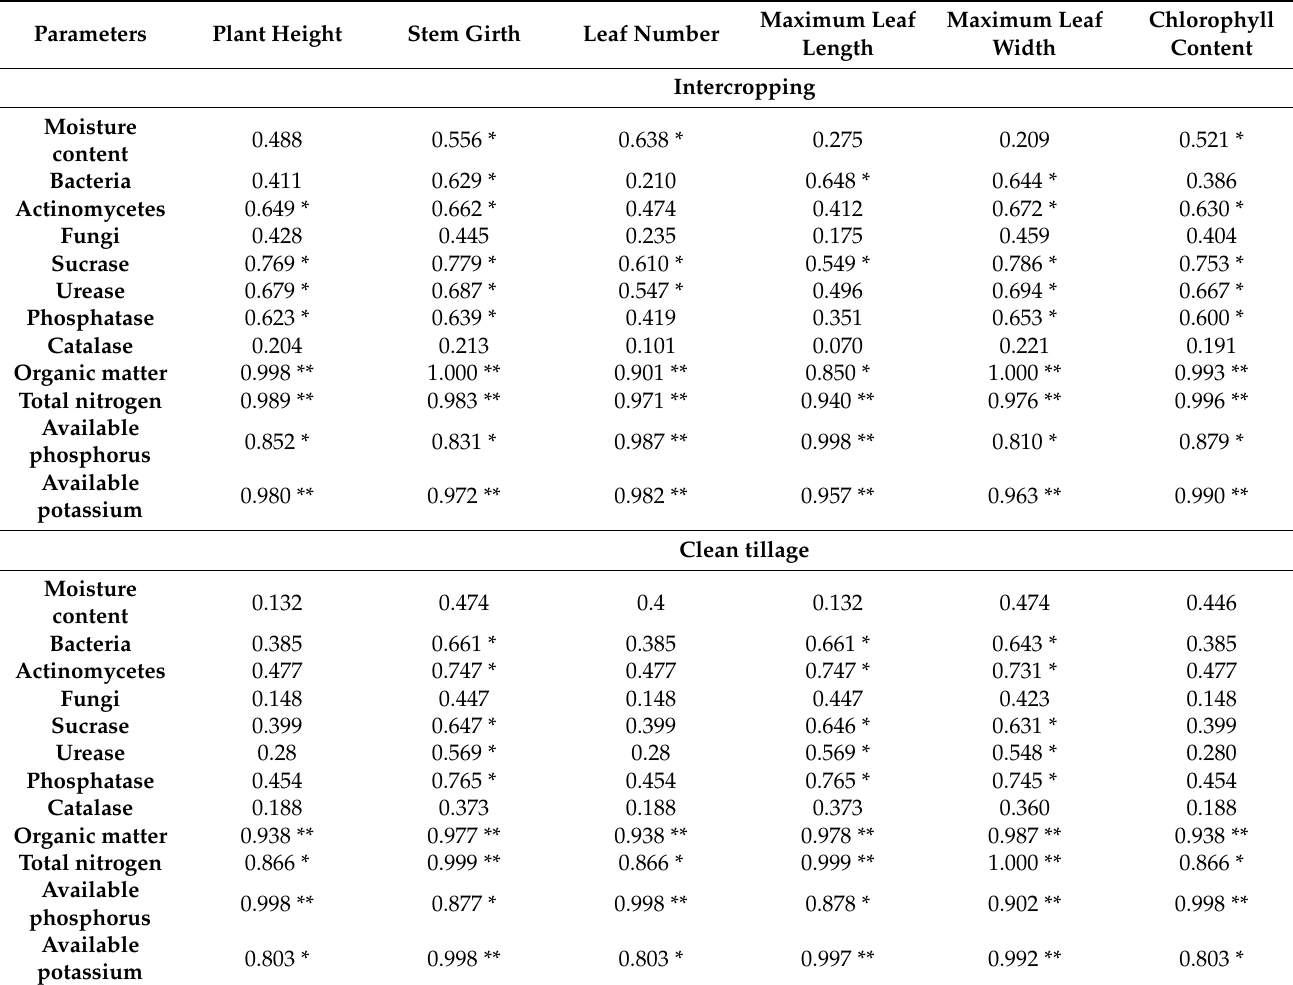
Table 4. Correlations between soil parameters and growth